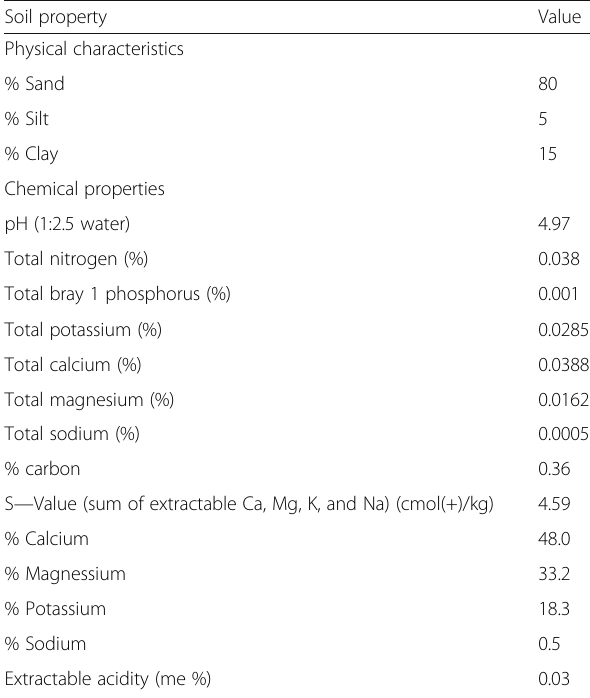
Table 1 Physicochemical properties of the soil prior to planting and